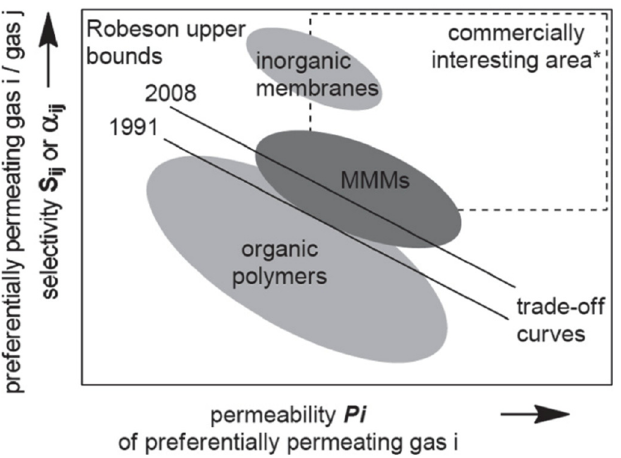
Figure 2. Schematic representation of the Robeson upper bounds (trade-off curves) from 1991 and 2008. Reprinted with permission from [20], copyright 2017 Wiley.